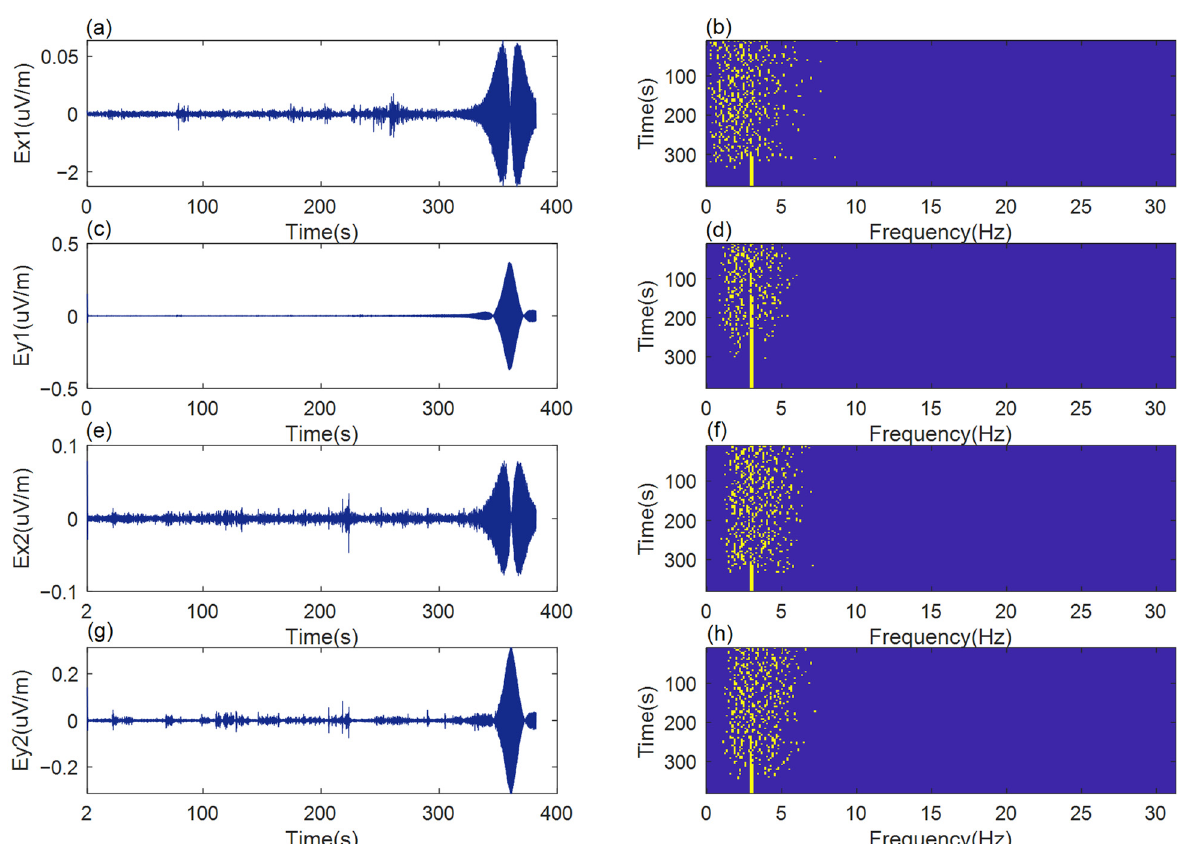
Figure 4. Low frequency electric field measurement and line spectrum detection at boat speed of 10 knots. ( a ) the longitudinal component of the bow sensor; ( b ) the result of target line spectrum extraction of E x 1 ; ( c ) the transverse component of the bow sensor; ( d ) the result of target line spectrum extraction of E y 1 ; ( e ) the longitudinal component of the stern sensor; ( f ) the result of target line spectrum extraction of E x 2 ; ( g ) the transverse component of the stern sensor; ( h ) the result of target line spectrum extraction of E y 2